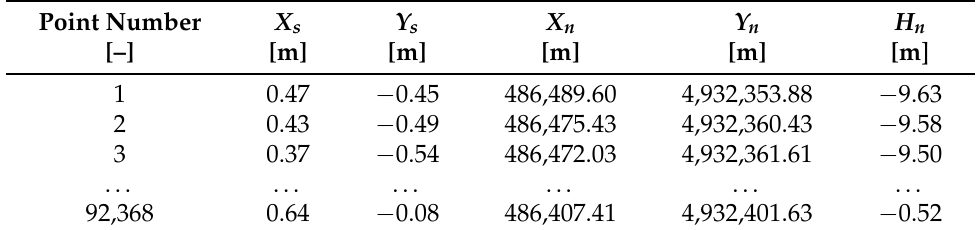
Table 5. Computed X n , Y n , H n . The coordinates are expressed in WGS84/UTM32N and account for both the distance between the GPS and SBES sensors mounted on the SWAMP along X and Y axes and the distance between GNSS and acoustic sensor positions along the Z axis.